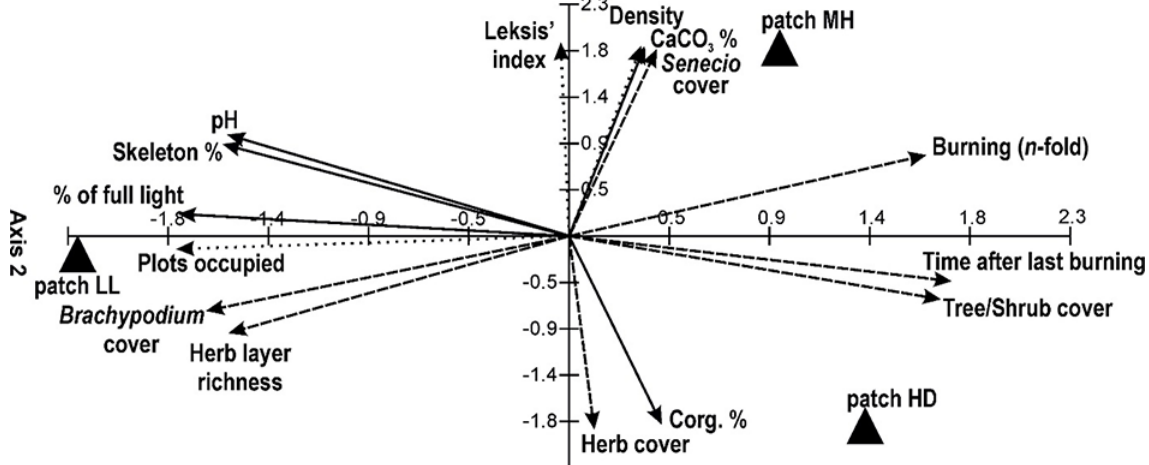
Figure 8 Ordination diagram showing the results of the PCA for the Senecio umbrosus population traits, vegetation characters, and environmental conditions; for details see Table